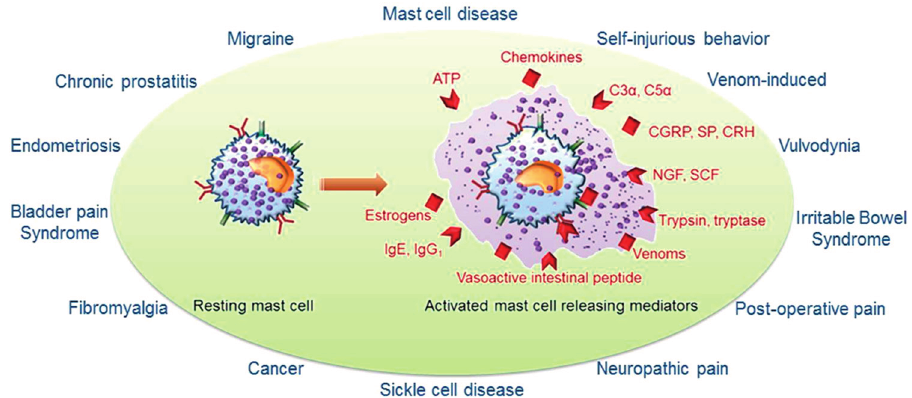
Figure 1. Mast cell-associated disease-specific pain syndromes, mast cell activation and its common activators: ATP (Adenosine tri-phosphate), chemokines, C3 α , C5 α (Complement 3 α , 5 α ), estrogens, immunoglobins (IgE, IgG 1 ), CGRP (calcitonin gene-related peptides), SP (substance P), CRH (corticotropin-releasing hormone), NGF (nerve growth factor), SCF (stem cell growth factor), trypsin, tryptase, venoms, vasoactive intestinal